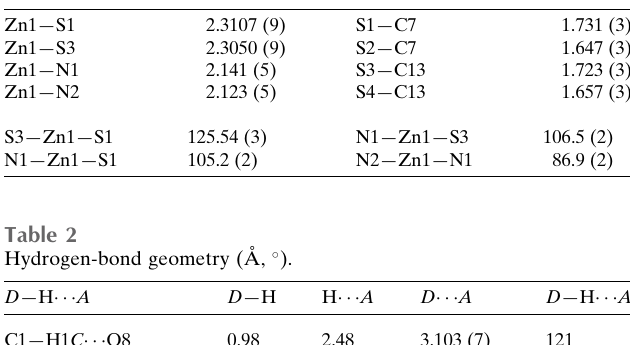
Table 1 Selected geometric parameters (A˚ , (cid:4) ).